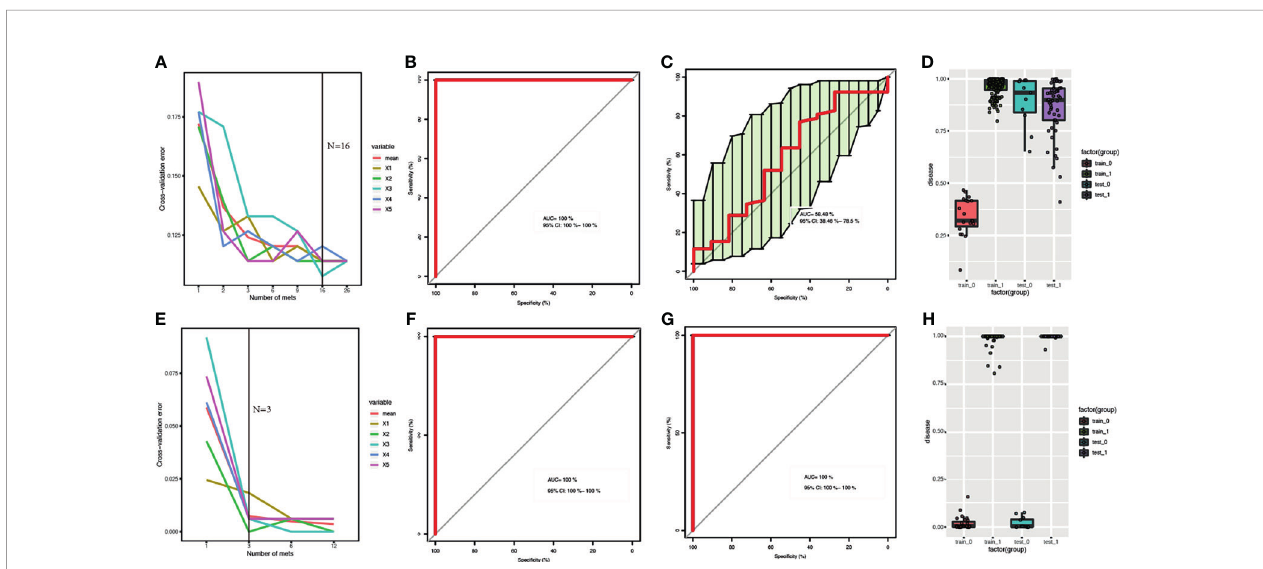
FIGURE 3 | Comparison of RF models based on metagenomics and metabolome features: (A, E) Distribution of 5 trials of 10-fold cross-validation error in random forest classi fi er. The red solid curve showed the average of the 5 trials, the black solid line indicated the number of picked features in the optimal set. (B, C, F, G) ROC curve and AUC for the training and test datasets, respectively. (D, H) Box-and-whisker plot presented the risk probability of B-CS. (A-D) for B-CS faecal microbiota. (E – H) for B-CS serum metabolome. The metabolomics results showed that both the training datasets and test datasets performed perfectly with (AUC = 100 %, 95% CI: 100 % – 100 %) (F – H) . We found that metagenomics performed relatively poorly on test datasets (AUC = 58.48 %, 95 % CI: 38.46 % – 78.5 %) (C, D) , although the training datasets showed good performance (AUC = 100 %, 95 % CI: 100 % – 100 %) (B – D) . RF, random forest; B-CS, Budd-Chiari syndrome; RF, random forest; ROC curve, Receiver Operating Characteristics curve; AUC, area under the curve; CI, con fi dence